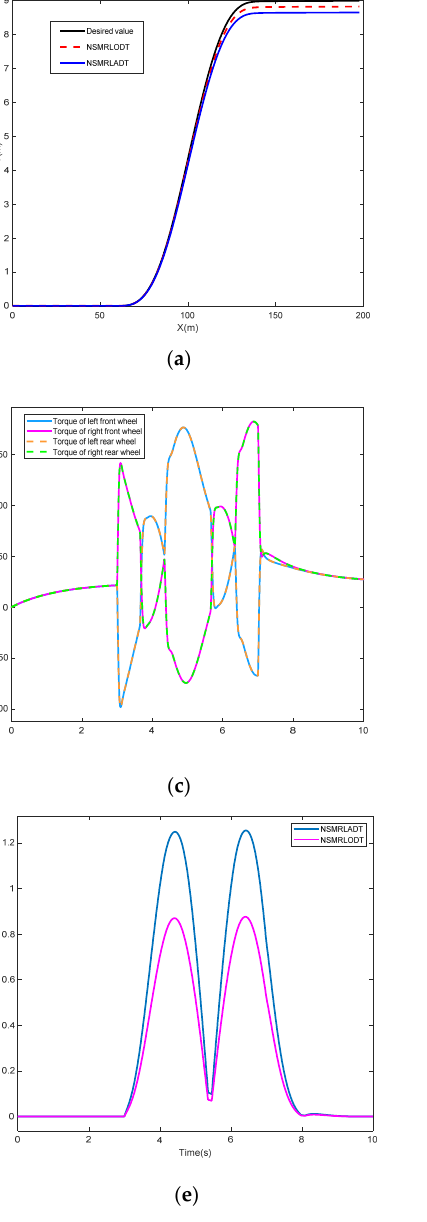
Figure 7. Simulation comparison of NSMRLADT and NSMRLODT under SLC maneuver. ( a ) Vehicle trajectory; ( b ) β β− phase planes; ( c ) ATD; ( d ) ODT; ( e ) total load rate of the four tires.